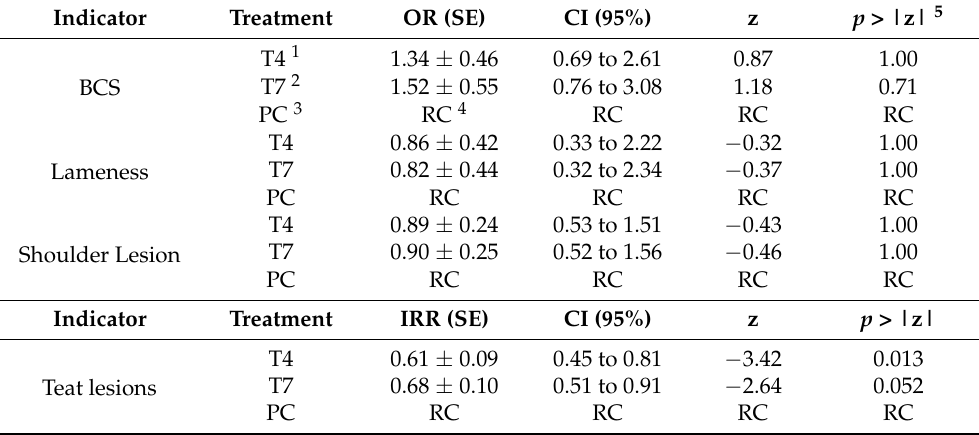
Table 4. Body condition score (BCS), lameness and shoulder lesion odds ratio (OR) ± SE, incidence rate ratio (IRR) ± SE of teat lesions, and 95% confidence interval (CI) for each treatment at loading and at